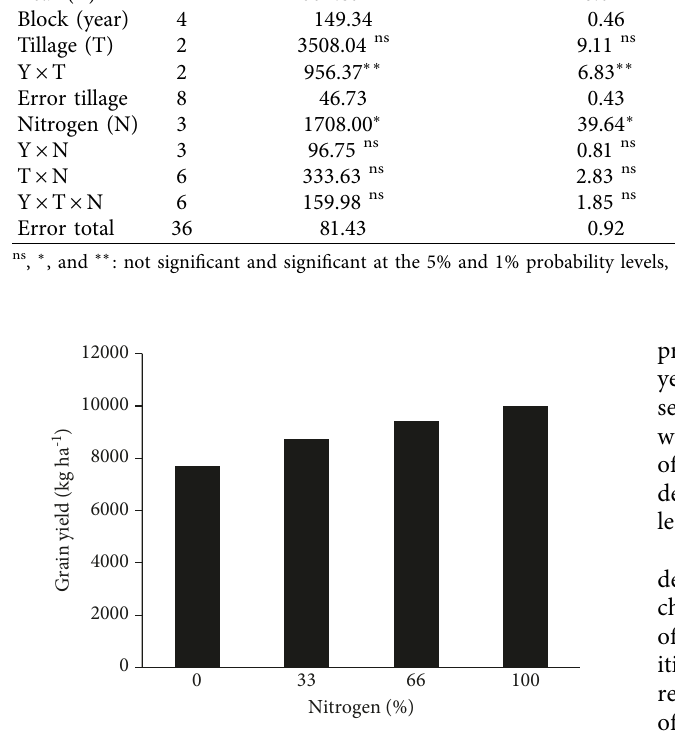
Figure 4: Effect of nitrogen fertilizer on grain yield of corn.